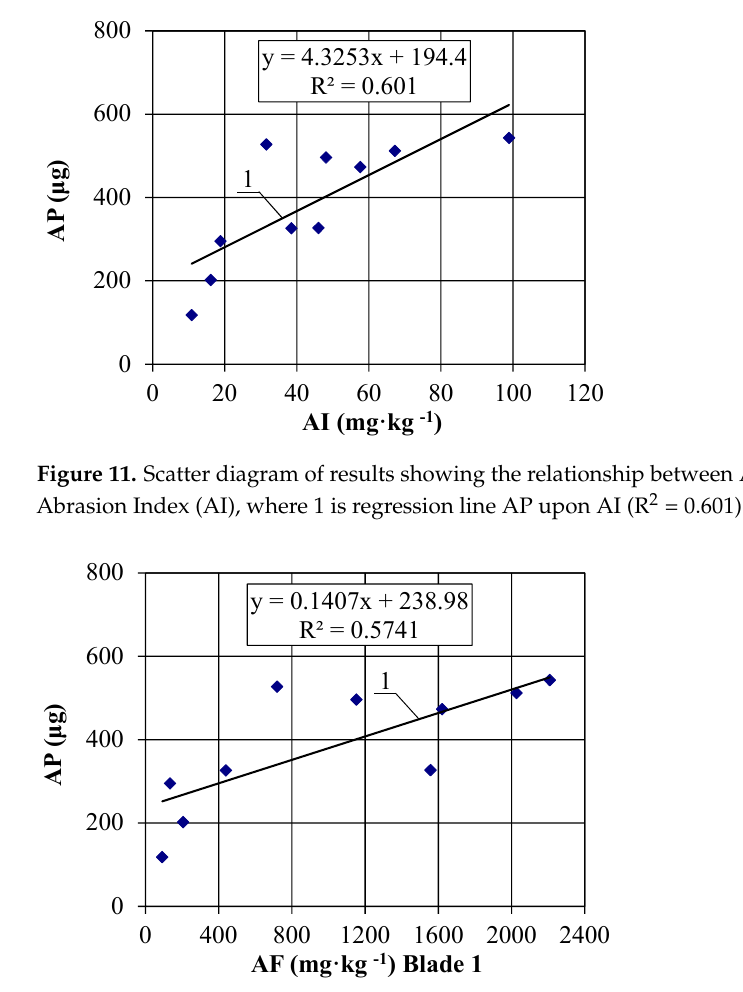
Figure 12. Scatter diagram of the results showing the relationship between Abrasion Potential (AP) and Abrasion Factor (AF), where 1 is regression line AP upon AF (R 2 = 0.5741).